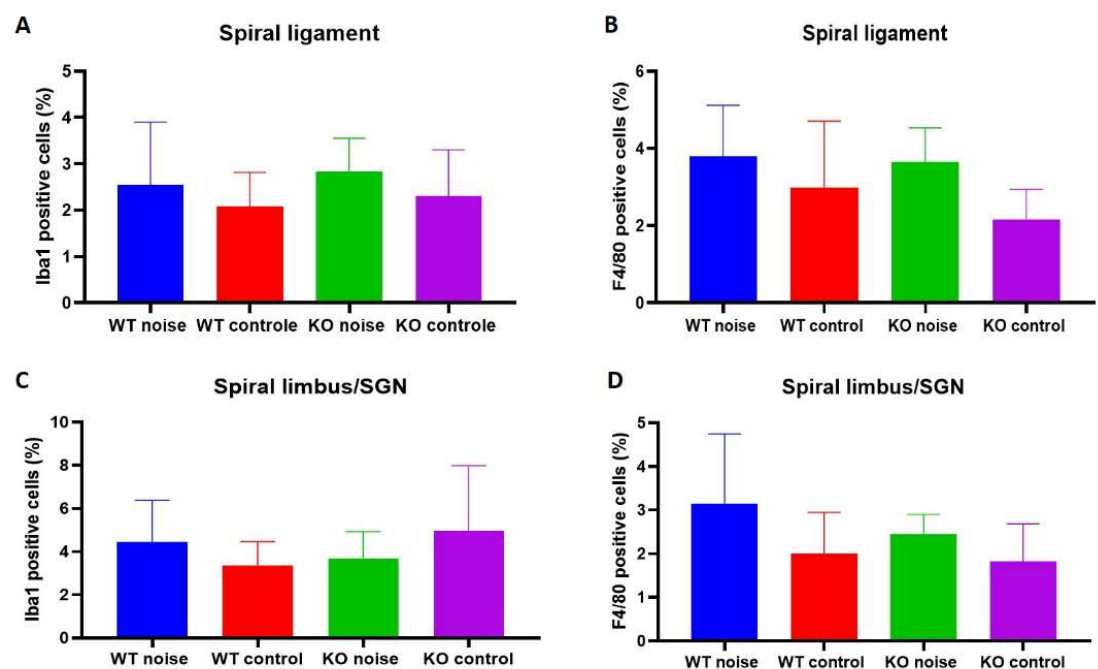
Figure 7. IBA1 staining in the spiral ligament ( A ) and the spiral limbus/spiral ganglion neuron region ( C ) across all groups. F4/80 staining in the spiral ligament ( B ) and spiral limbus/spiral ganglion neuron region ( D ) show no significant difference in F4/80 positive cells between Coch +/+ mice exposed to noise ( n = 13), Coch +/+ control mice ( n = 9), Coch − / − mice exposed to noise ( n = 13) and Coch − / − control mice ( n = 13). Positive cells were counted using ImageJ and divided by the total amount of cells to calculate a percentage.